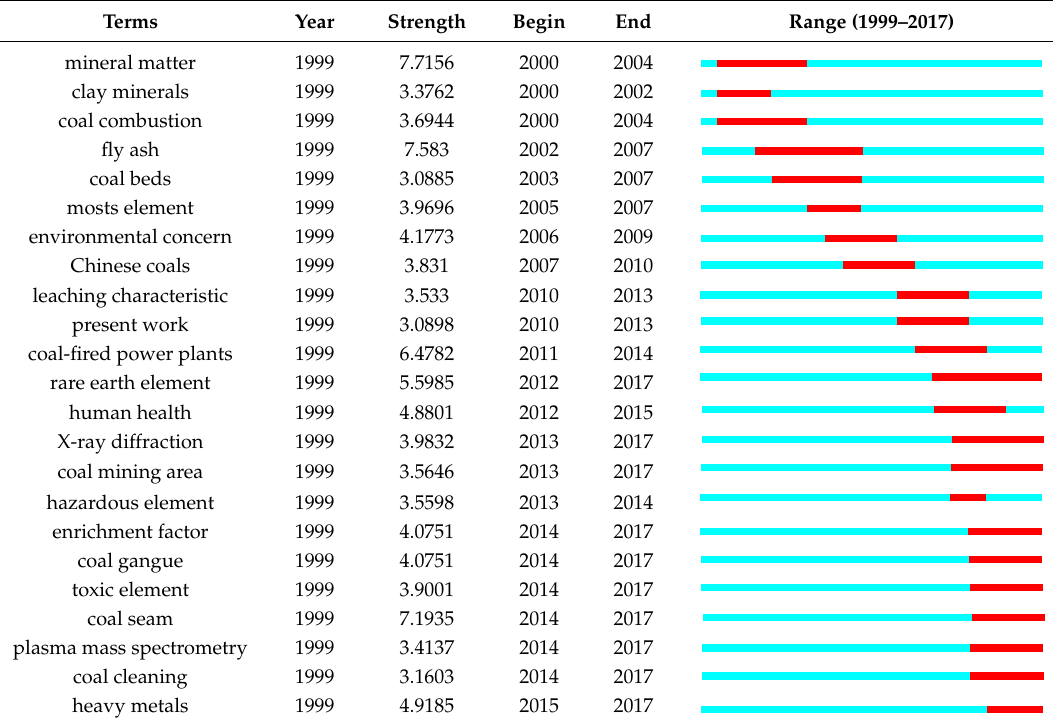
Table 6. Top 25 Terms with the Strongest Citation Bursts of trace elements in coal and ash in ascending order of Beginning years.